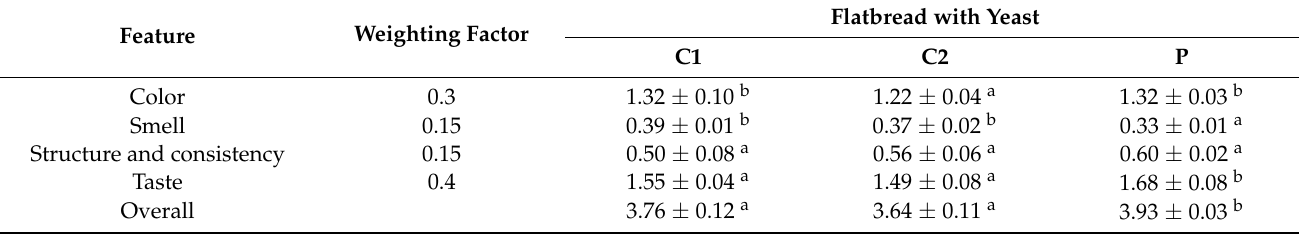
Table 4. Results of the flatbread evaluation with the 5-point rating scale .